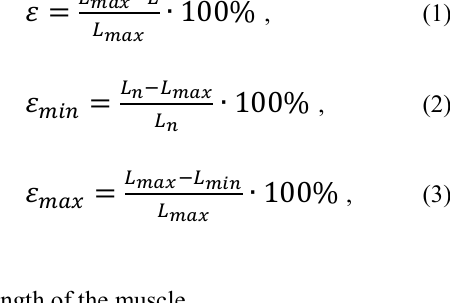
Fig. 6. The isobaric characteristics of the pneumatic artificial muscle PAM-20-330.